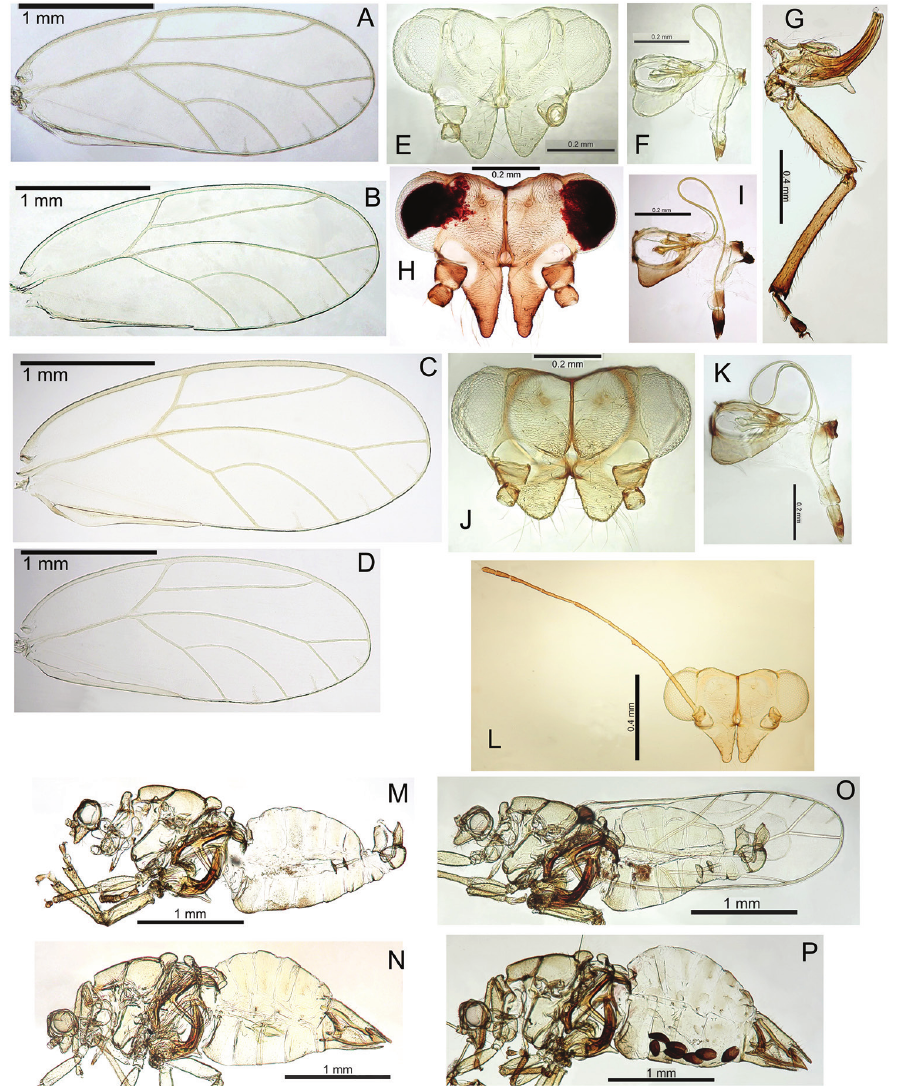
Figure 31. Pariaconus oahuensis sp. n. A, B, C, D fore wing: A form oahuensis B form tenuis C form latus (Waianae, Oahu) D form latus (Koolau, Oahu) E, F form oahuensis (Northern Waianae, Oahu): E head F proboscis G, H, I form oahuensis (Central Waianae, Oahu): G hind leg H head (uncleared ocular tissue) I proboscis J, K form latus (Waianae, Oahu): J head K proboscis L head and antenna, form oahuensis (Aiea, Oahu) M male, form oahuensis (Aiea, Oahu) N female, form tenuis (Koolau, Oahu) O male, form latus (Koolau, Oahu) P female, form latus (Aiea, Oahu). tion site suggesting microecological divergence may play a role in explaining this di- versity; form oahuensis is the most widespread, form tenuis and form latus are generally less common; however form tenuis appears to be the more common in the